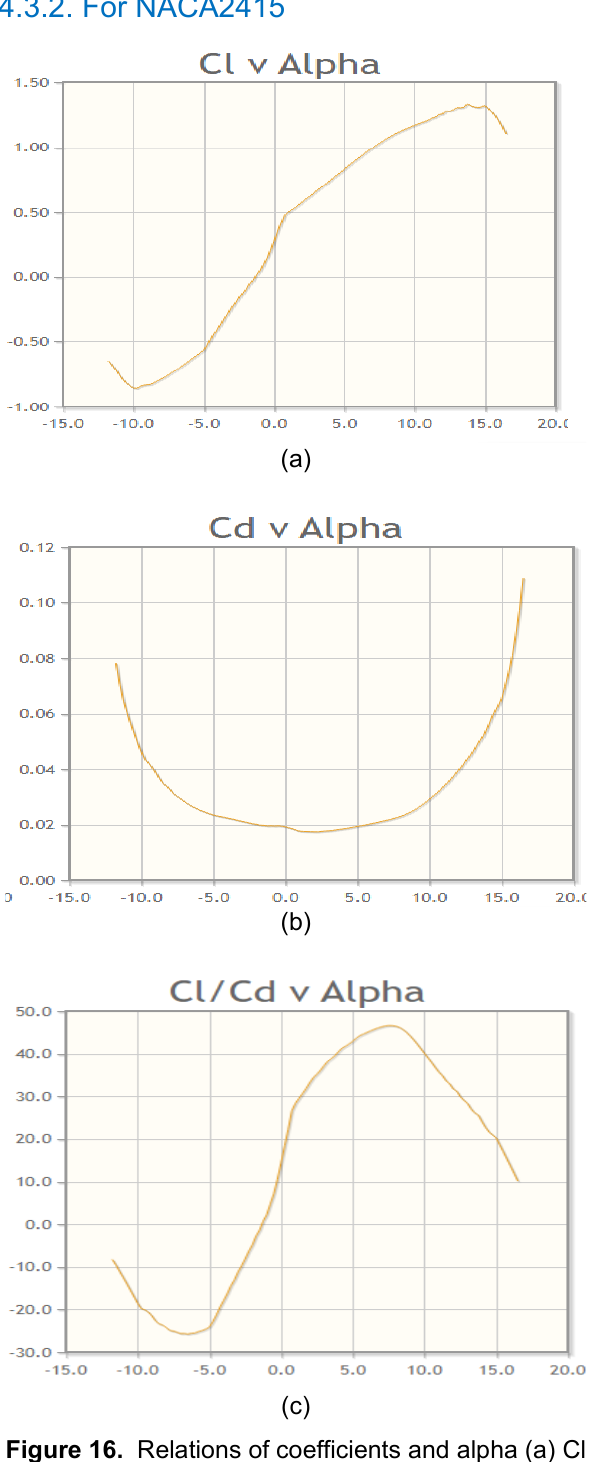
Figure 16. Relations of coefficients and alpha (a) Cl v alpha, (a) Cd v alpha and (a) Cl/Cd v alpha for